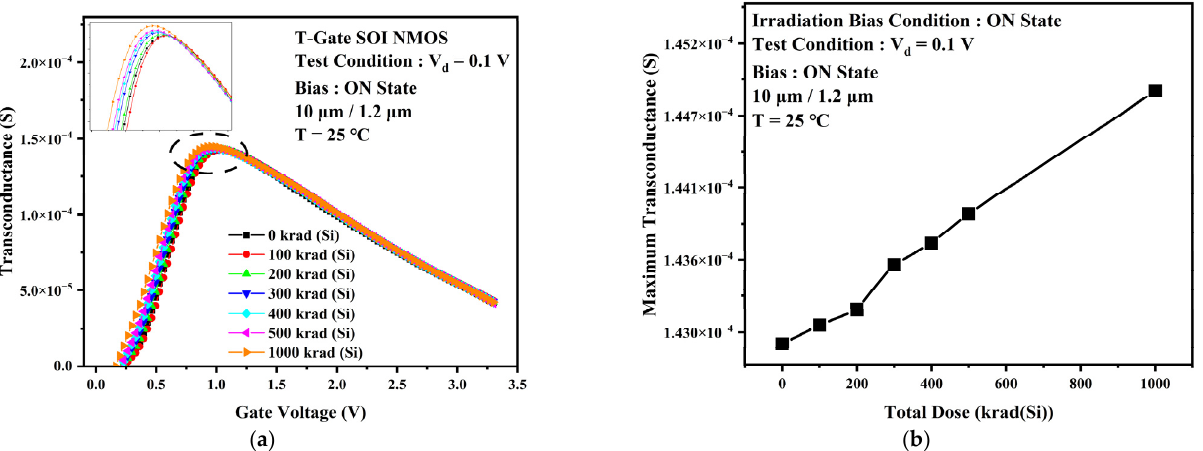
Figure 7. ( a ) Transconductance curves of devices at different irradiation doses. ( b ) Maximum transconductance values at different irradiation doses.